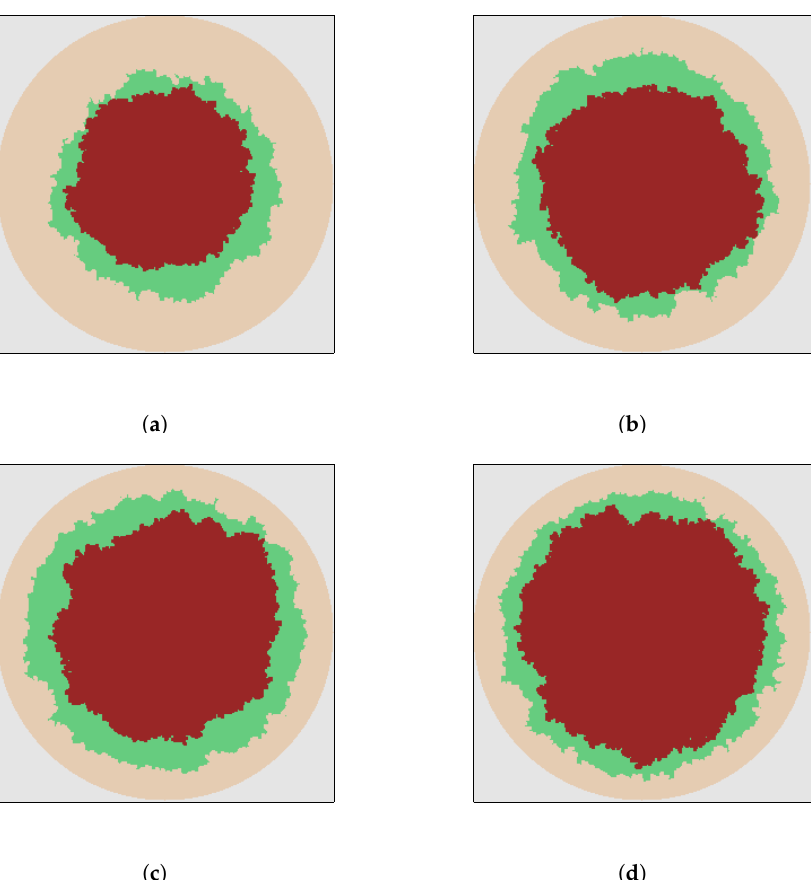
Figure 6. Eden model simulation of epithelialization and infection for different bacteria growth rates. is wound space, is epithelialization, and is bacteria growth. The amount of epithelialization in stalled wounds for different bacteria growth rates showing the severity of infection are given in ( a – d ). The bacteria growth rates are ( a ) half, ( b ) equal, ( c ) one and half times, and ( d ) two times the growth rate of